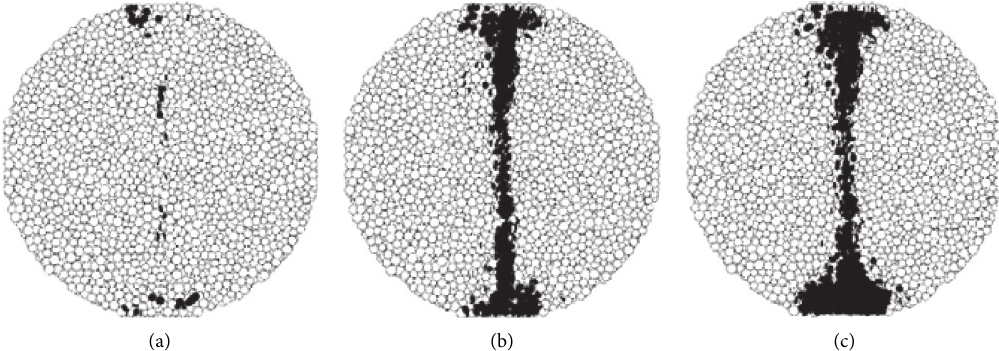
Figure 22: Microcracks distribution in CCNBD specimen (C3). (a) Crack initiation. (b) Crack growth. (c) Sample